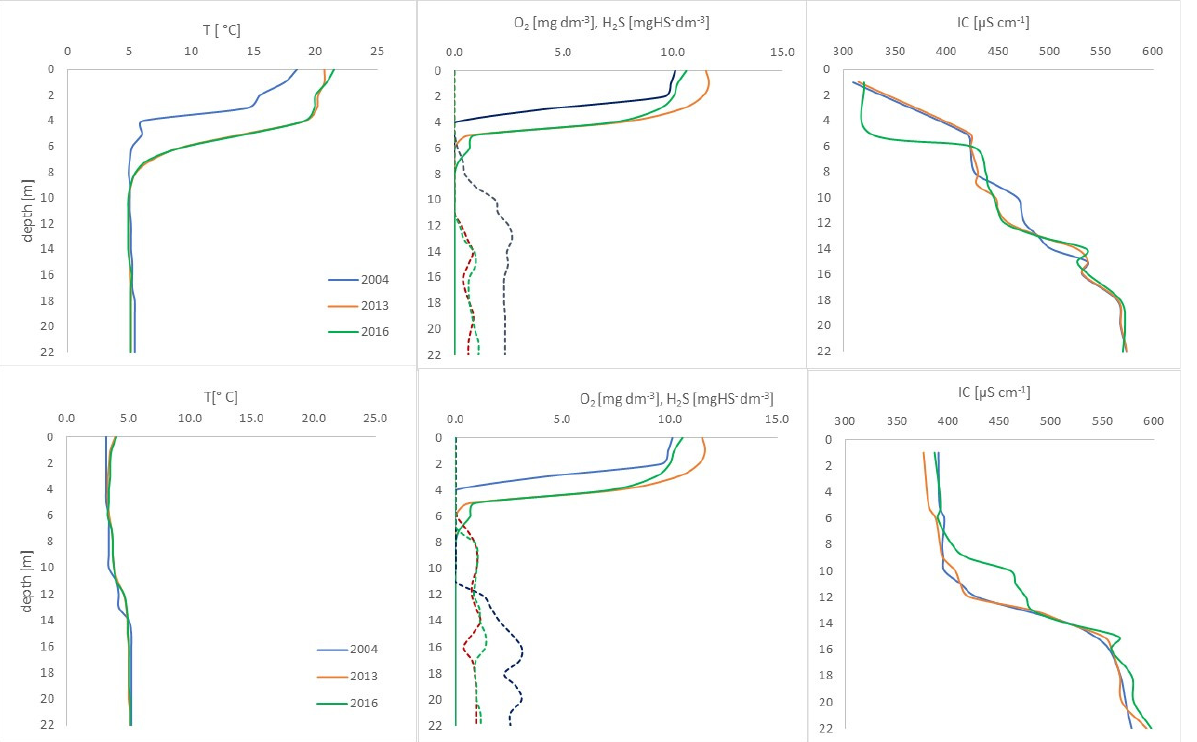
Figure 3. Examples of the vertical thermal profile ( a ), the oxygen and hydrogen sulphide (dot line) concentrations ( b ), and conductivity ( c ) in Lake Starodworskie in August ( upper panel) and December ( lower panel). Table 2. Results of the Mann–Kendall analysis. Significant results ( p < 0.05) are presented. Other results are indicated as NS (nonsignificant).